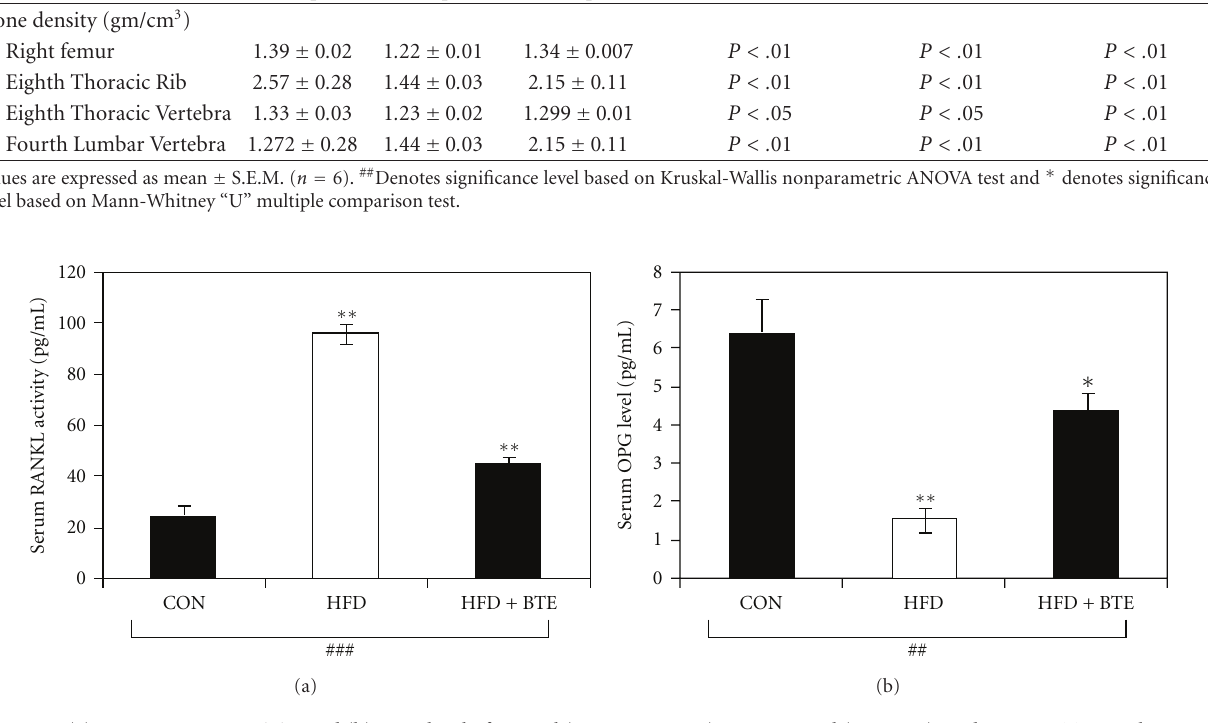
Figure 3: (a) Serum RANKL activity and (b) OPG level of control (CON; Group A), HFD treated (Group B), and HFD + BTE supplemented (Group C) groups of rats. Values are expressed as mean ± S.E.M. ( n = 6). ### P < . 001 denotes significance level based on Kruskal-Wallis nonparametric ANOVA test, ## P < . 01 denotes significance level based on Kruskal-Wallis nonparametric ANOVA test, ∗∗ P < . 001 denotes significance level based on Mann-Whitney “U” multiple comparison test, and ∗ P < . 05 denotes significance level based on Mann-Whitney “U” multiple comparison